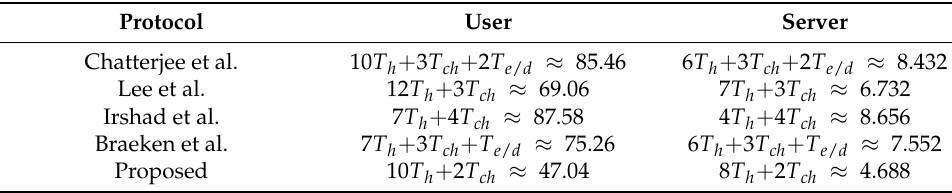
Table 6. Comparison of computing costs (millisecond).